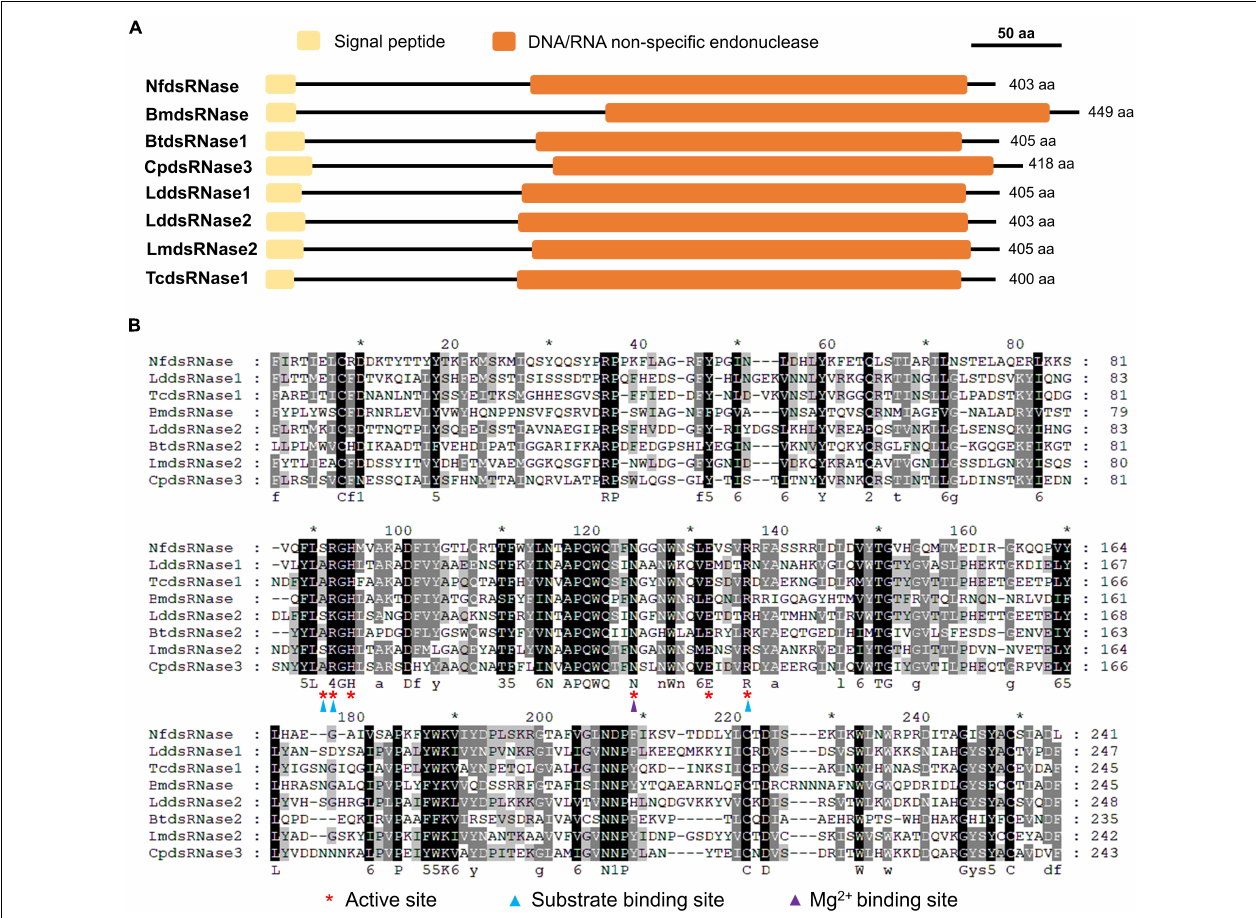
FIGURE 2 | Analysis of deduced amino acid sequences of NfdsRNases with well-characterized dsRNases from other insects. (A) Schematic diagrams of key function domains of dsRNases. Yellow boxes indicate predicted signal peptides; Orange boxes denote the DNA/RNA non-specific endonuclease domains. (B) Multiple sequence alignment of the DNA/RNA non-specific endonuclease domains in insect dsRNases (Nf, Nylanderia fulva ; Bm, Bombyx mori ; Bt, Bemisia tabaci ; Cp, Cylas puncticollis ; Lm, Locusta migratoria ; Ld, Leptinotarsa decemlineata ; Tc, Tribolium castaneum ). Red asterisks indicate the active sites. Substrate- and Mg 2 + -binding-sites are marked with blue and purple triangles, respectively. Numbers under the aligned sequences denote amino acid similarity groups of DN, EQ, ST, KR, FYW, and LIVM, respectively.